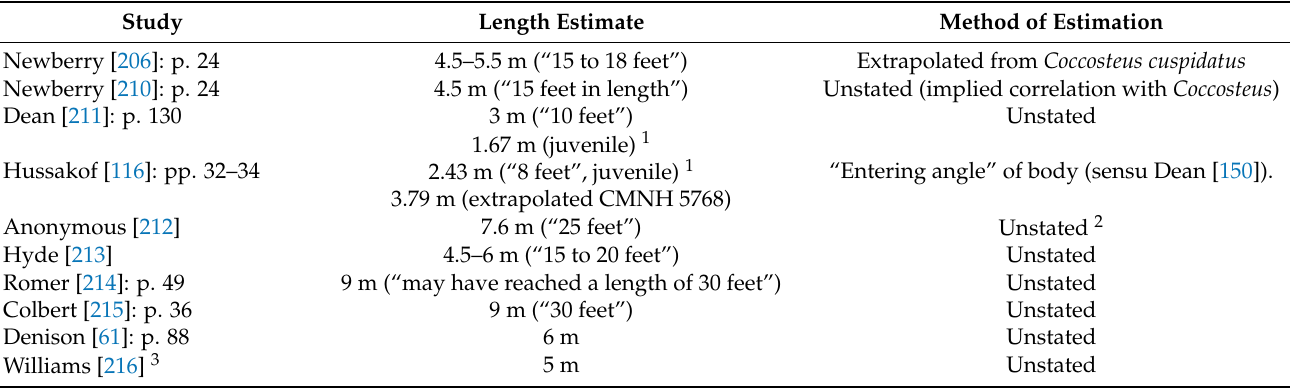
Table 7. Previous length estimates of Dunkleosteus terrelli arranged in chronological order and their methodology. “Unstated” refers to estimates where the methodology used to calculate these length estimates is undefined and no citation is made to length estimates in prior